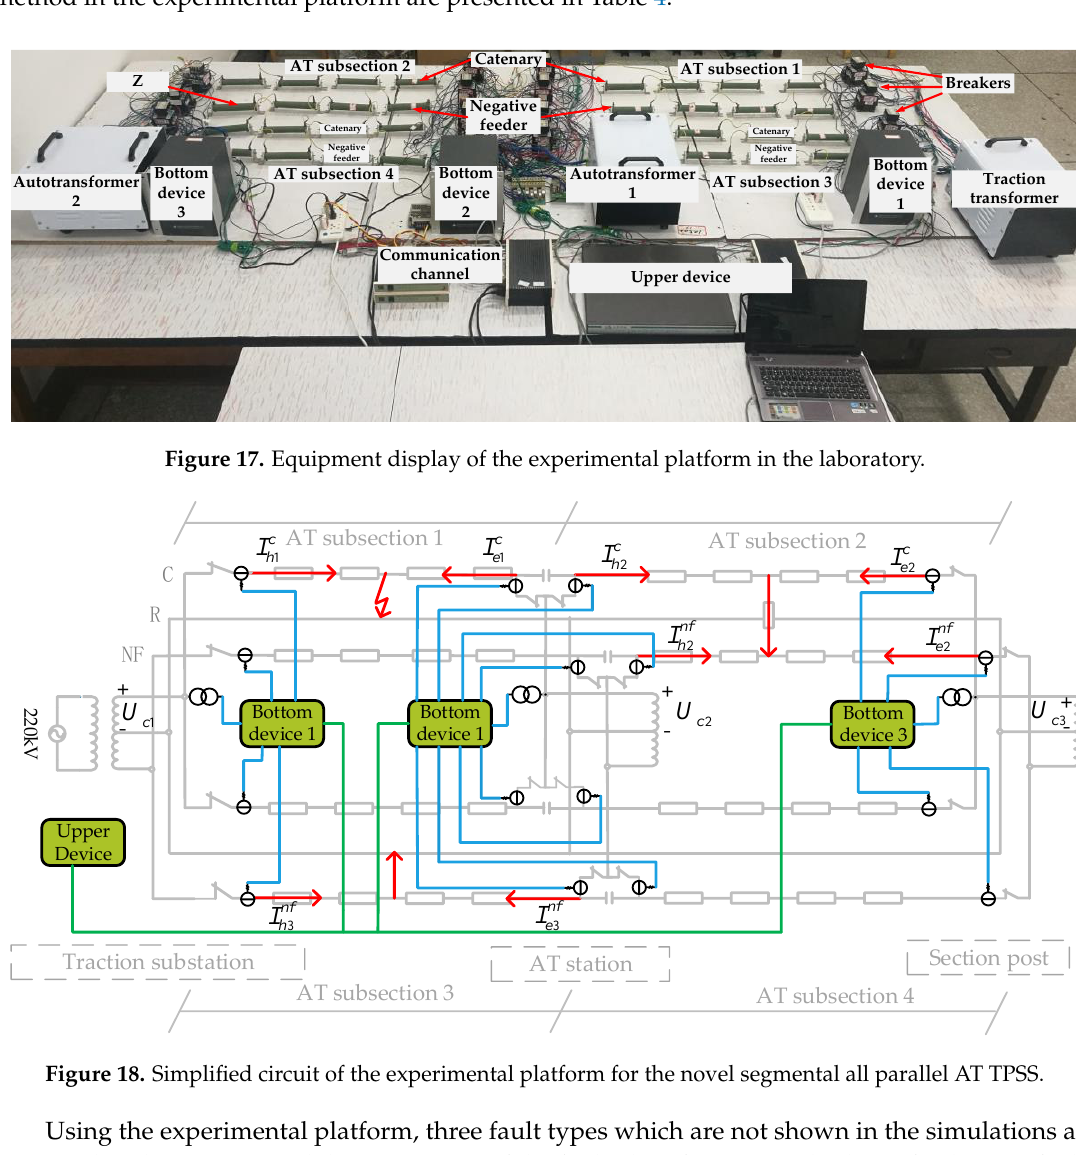
Table 4. Parameters of the fault identification method in the platform.